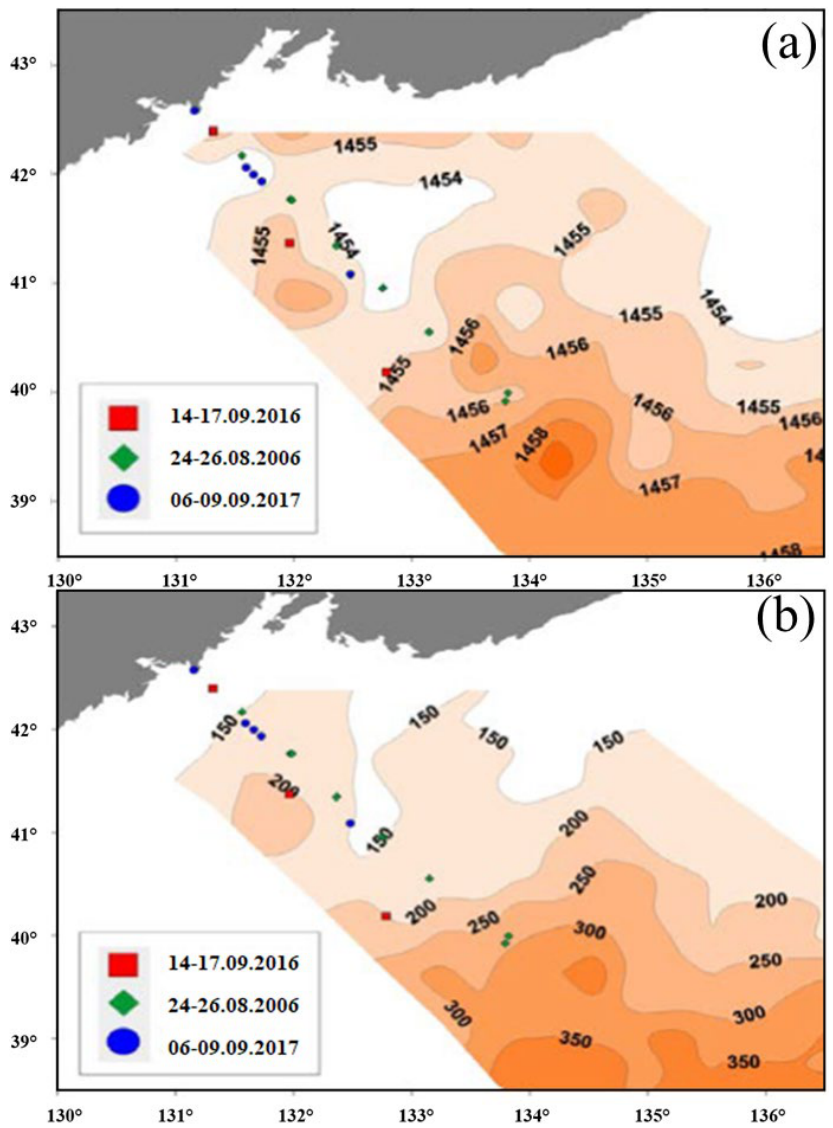
Figure 12. Map of depths and sound speeds on the USC axis, built on the basis of long-term observations for August: ( a ) Average sound speed (m/s) on the USC; ( b ) the USC depth of occurrence (m) based on the results of long-term data and the position of the control CTD measurements in the summer-autumn period.